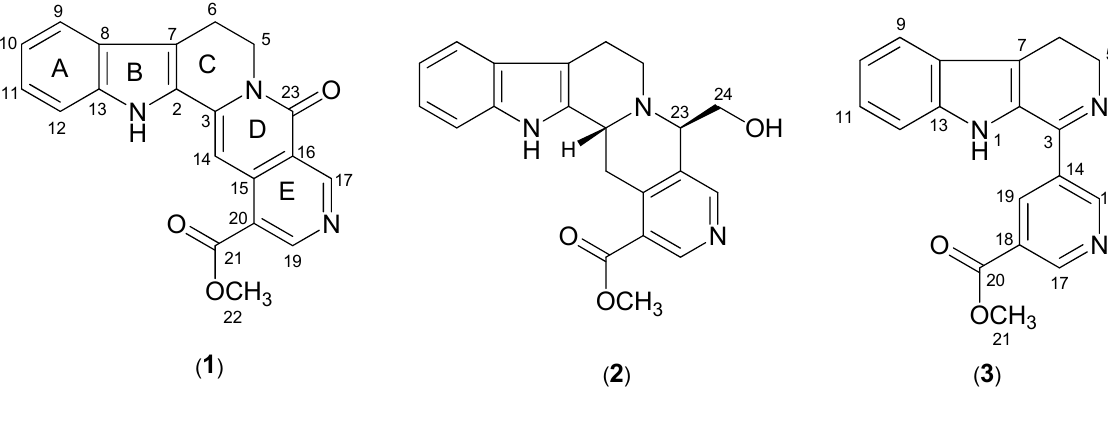
Figure 1. Structures of neonaucline ( 1 ), cadamine ( 2 ), and naucledine ( 3